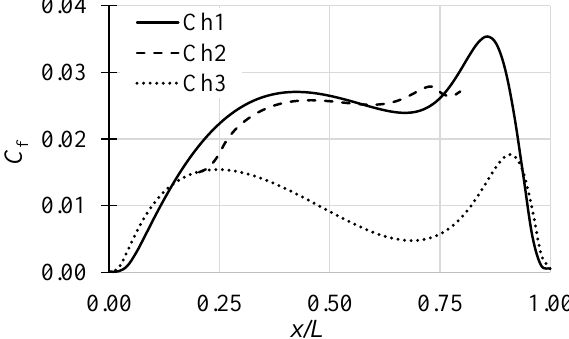
Figure 14. Skin friction coefficient at Re = 100.